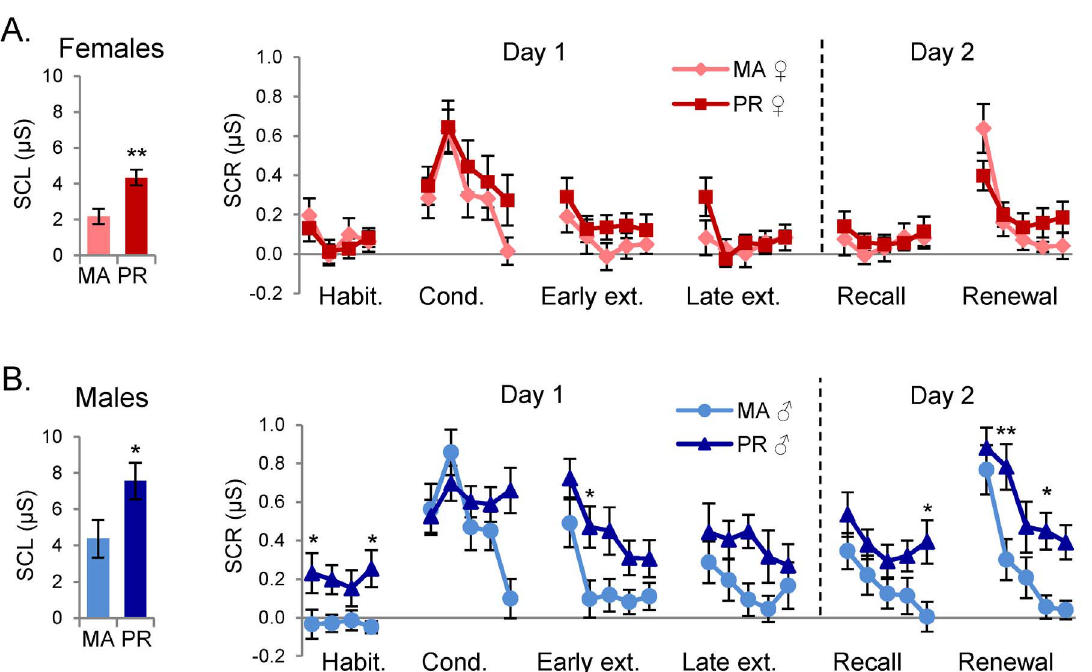
Fig. 2. Baseline skin conductance level (SCL) and skin conductance responses (SCR) to CS + across all experimental phases in males and females at both sites. A. SCL and responses to CS + in females in Massachusetts (MA) and Puerto Rico (PR). B. SCL and responses to CS + in males in Massachusetts (MA) and Puerto Rico (PR). Habit. 5 Habituation, Cond. 5 Conditioning, Ext. 5 Extinction, m S 5 microsiemens. *p , 0.05; **p ,